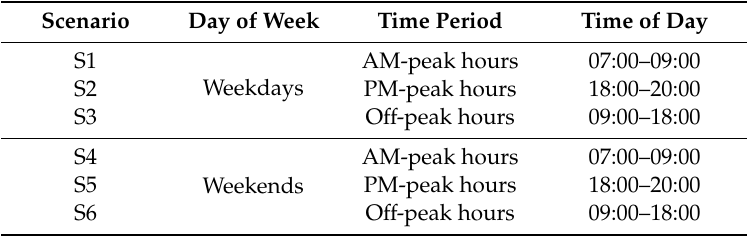
Table 1. Description of the six investigated